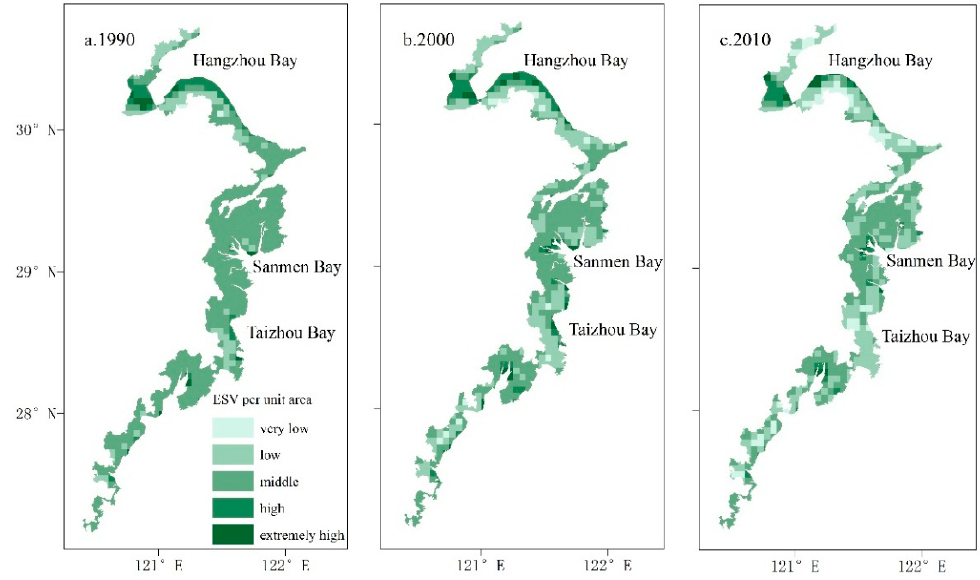
Figure 5. The distribution of ESV in the coastal zone in Zhejiang Province from 1990 to 2010. ( a ) the distribution of ESV in the year 1990; ( b ) the distribution of ESV in the year 2000; ( c ) the distribution of ESV in the year 2010.